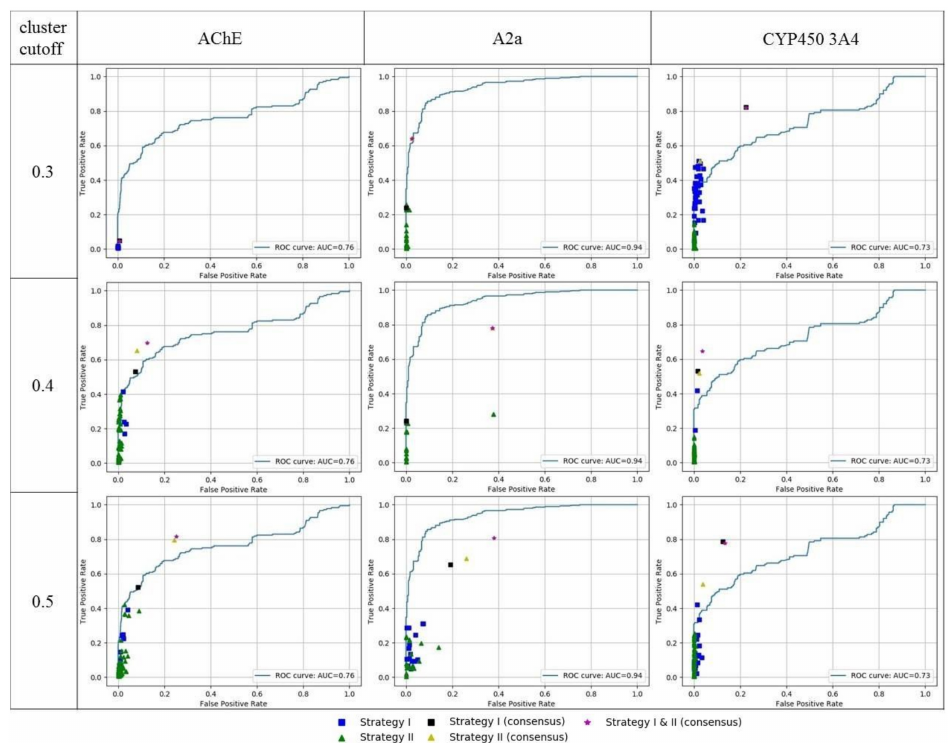
Figure 8. Performance of 3D ligand-based pharmacophore models and comparison with the best results of similarity search based on 2D pharmacophore